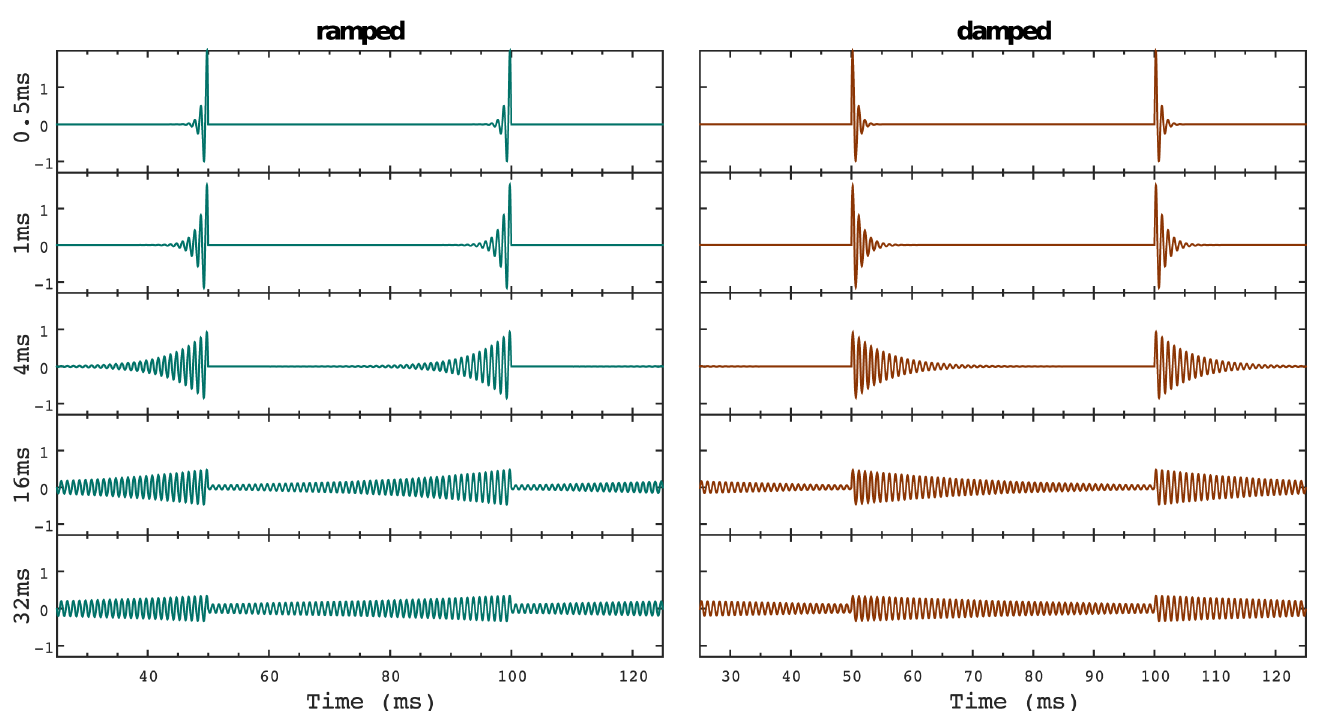
Fig 1. Waveforms of the ramped and damped sinusoids. Ramped (left) and damped (right) sinusoidal waves with half-life times ( T 1/2 ) of 0.5, 1, 4, 16, and 32 ms used in the experiment. Note the two periodicities present in the stimuli corresponding to the carrier (1000 Hz) and the repetition period (20 Hz) of the ramped/damped